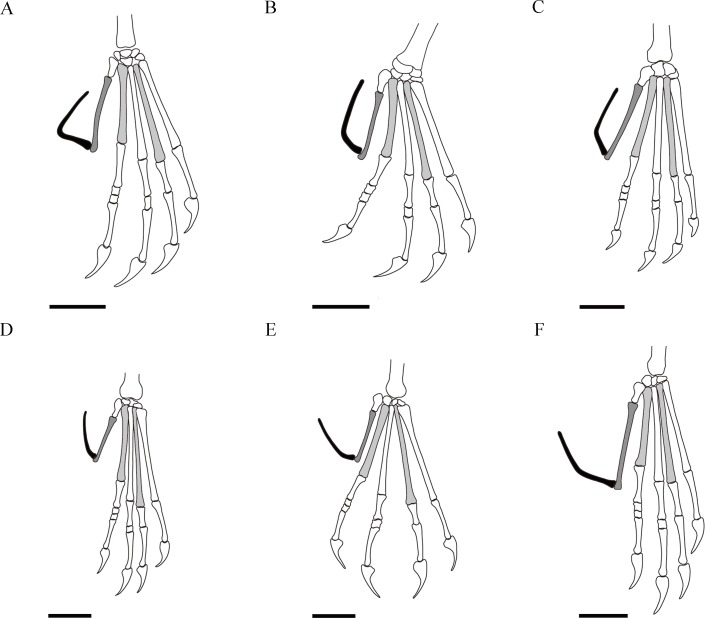
Reconstructions of wukongopterid feet with all metatarsals II of the same size.Showing metatarsals II and IV in light grey, first phalanges of pedal digit V in dark grey and second phalanges in black. Scale bars: 10 mm. (A) Wukongopterus (based on Wang et al., 2009). (B) Darwinopterus linglongtaensis (based on Wang et al., 2010). (C) Darwinopterus robustodens (based on Lü et al., 2011a). (D) Holotype of Kunpengopterus sinensis (based on Wang et al., 2010). (E) Kunpengopterus sinensis (IVPP V 23674). (F) IVPP V 18403/ZMNH M8802 (wukongopterid with eggs, based on Lü et al., 2011b; Wang et al., 2015).